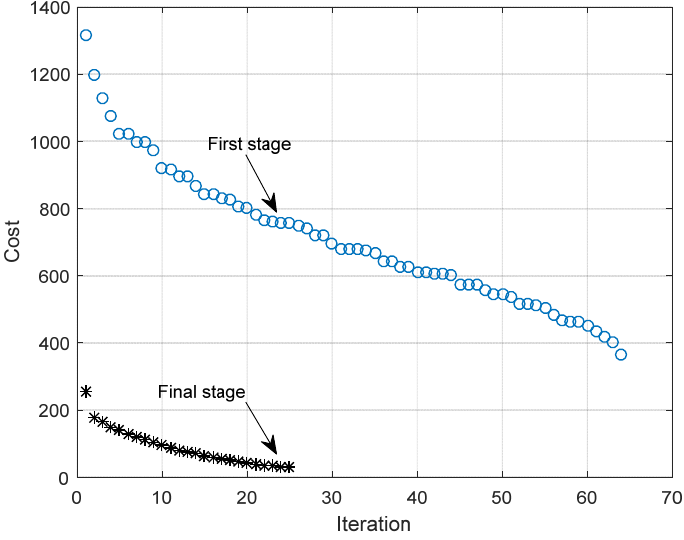
Figure 2. Cost trajectory example of the proposed algorithm.